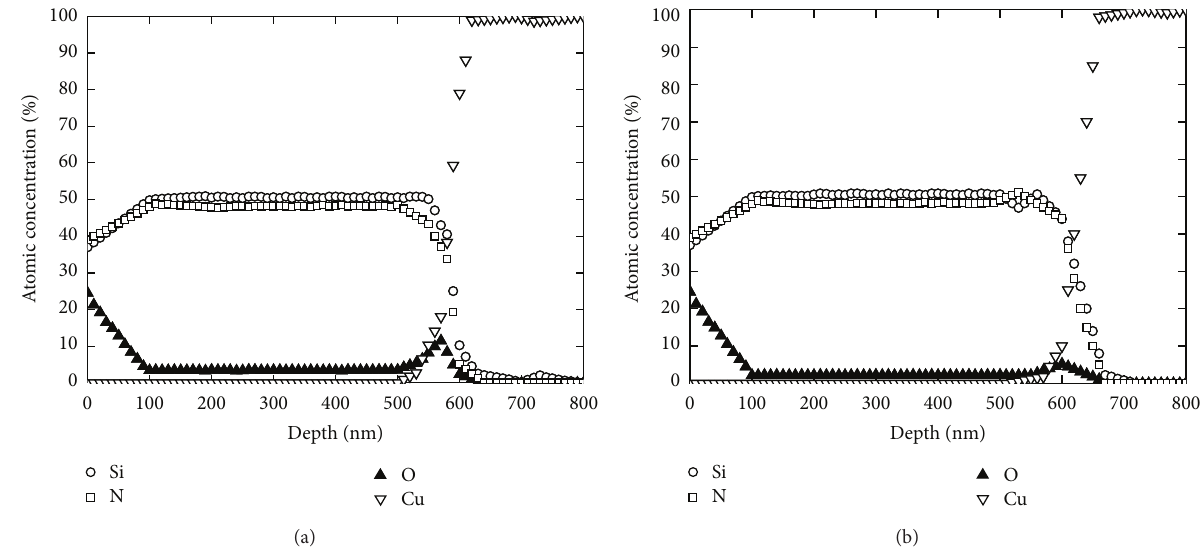
Figure 1: AES depth profile of Si, N, O, and Cu atomic concentrations in the Cu/SiN multilayer structures (a) without plasma treatment and (b) with 30 s NH 3 plasma